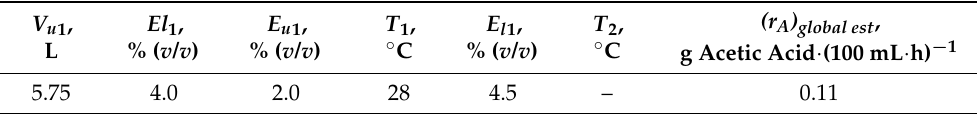
Table 4. Values of the operational variables needed to minimize ( r A ) global est .